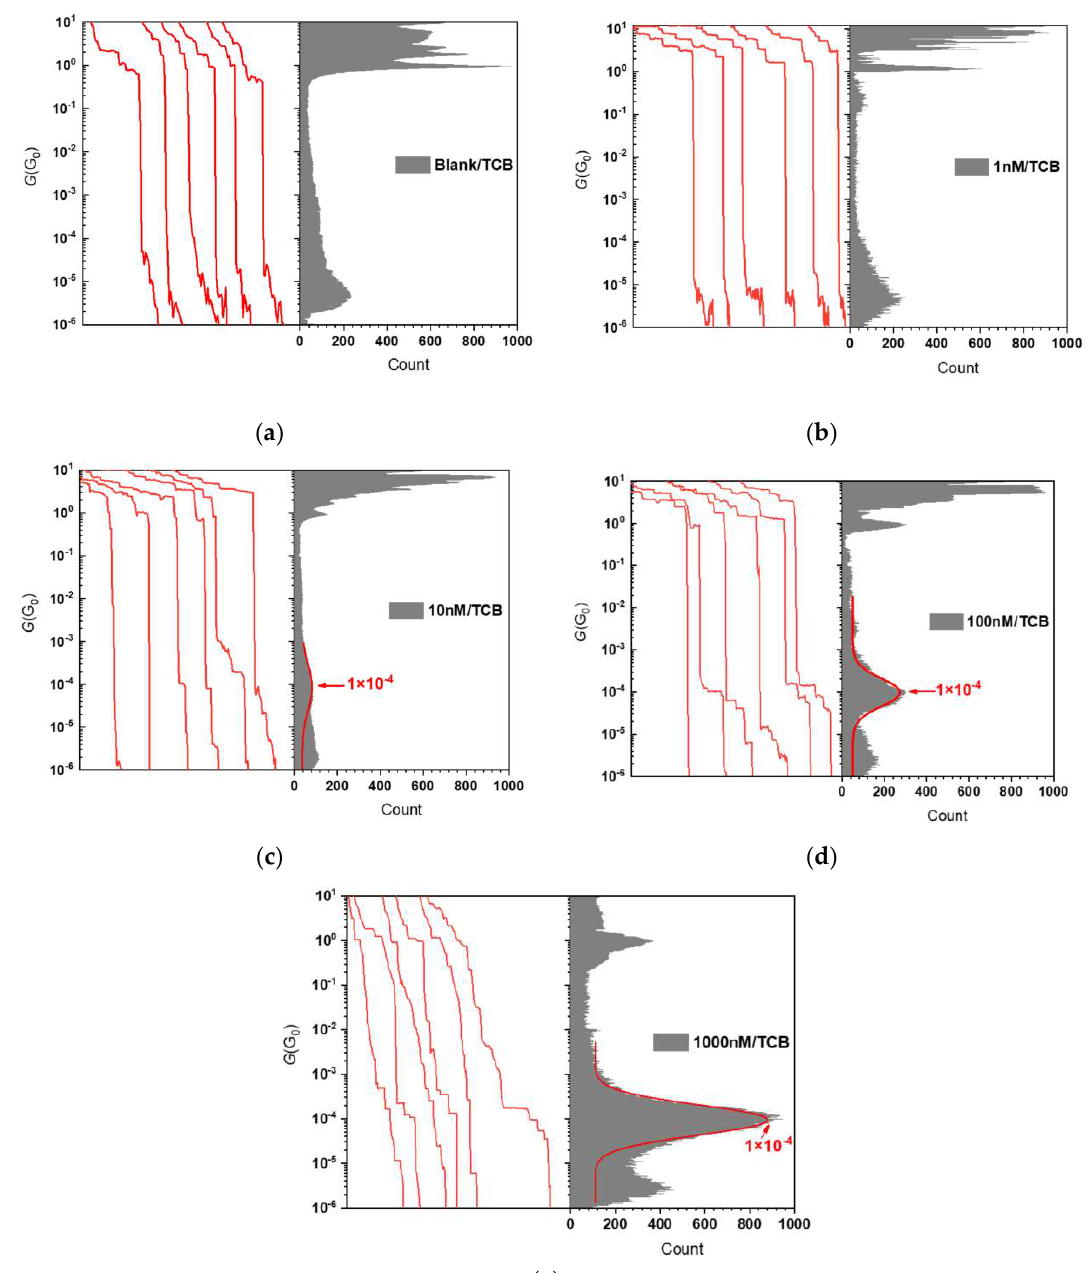
Figure 4. Conductance histograms under various ODT concentrations: ( a ) 0 nM (blank test), ( b ) 1 nM, ( c ) 10 nM, ( d ) 100 nM, and ( e ) 1000 nM. Solid curves are Gaussian fits to the distributions at <10 −3 G 0 .